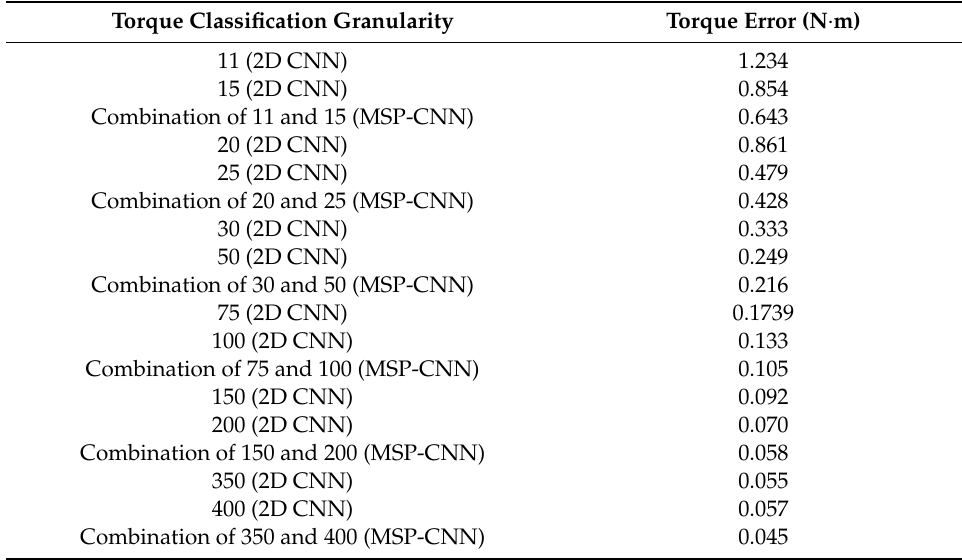
Table 3. Torque estimation errors before and after applying the MSP-CNN model.